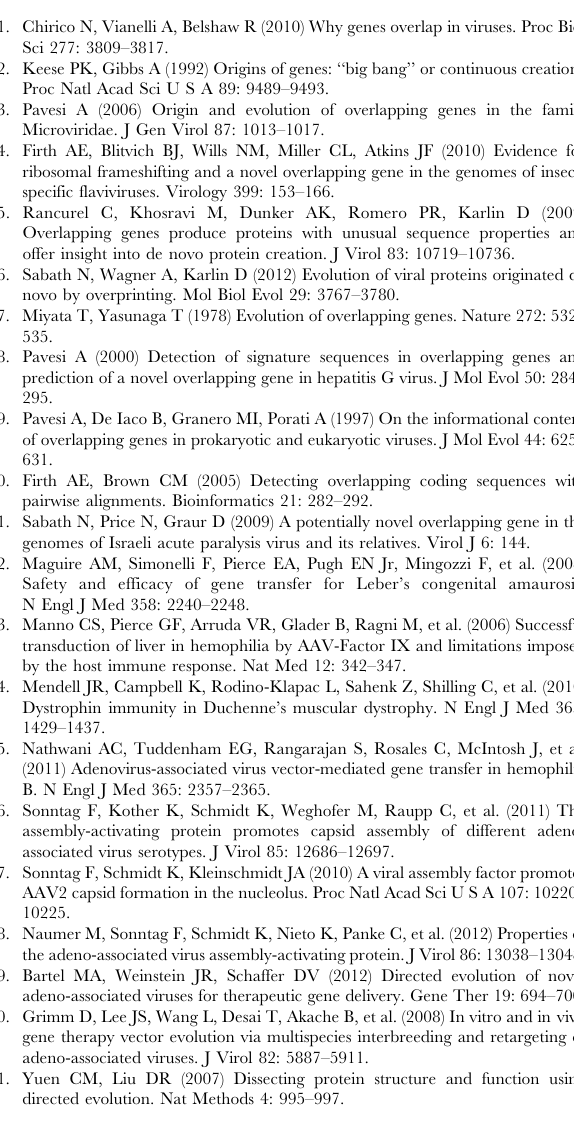
Table S1 The amino acid compositions (%) in the viable 143 VP and 492 AAP heptapeptide mutants. Table S2 The amino acid compositions (%) in the original VP and AAP heptapeptide libraries ( i.e. , Lib-0). Table S3 Statistical comparisonof amino acid compositionsbetween